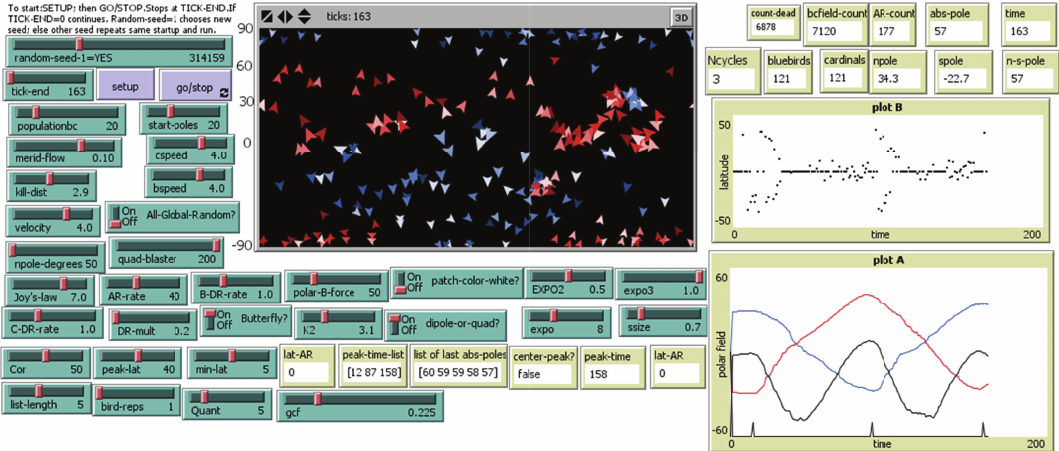
Figure 1: Shown is the Field Mapping version 1p07 interface. This directs cellular automata to follow our algorithms written in the Netlogo 4.1.3 language. The blue slider bars on the left and below allow various parameters to be set, and the display in the center progresses through time, allowing large-scale solar fields to be “mapped.” The time history of the fields is displayed in the two plots to the right of the interface. The white monitors also provide instantaneous values of various parameters to be displayed. There are two graphs on the right; the lower one labeled Plot A, displays the polar field variations. In it are three colored curves: blue, red, and black. The blue curve displays the amount and sign of the magnetic flux in the northern magnetic pole, namely, the mean field above 60 degrees latitude. The red curve, similarly counts the mean field in the Southern polar region. The black curve marks the Absolute Value Sum of the red and blue curves. So, this curve in black displays the amount of magnetic flux in the polar regions. It has been artificially placed 60 units downwards, for increased clarity, so 0 lies at the bottom of the graph. It essentially reaches a peak, during a solar cycle minimum. The very astute observer will observe a fourth black curve at the bottom of the graph. This last curve at the bottom of Plot A shows when the total polar field values reach a “peak.” This is taken as the start of a new cycle and is shown as a uniform tiny “blip” in this bottom curve. Thus one can count solar cycles with these blips. The second plot, towards the right of the display, is Plot B. It shows the mean latitude of all active regions born during a tick unit of time. In this manner one may observe the solar cycle “butterfly graph,” although only roughly, as the graph program does not average, and so